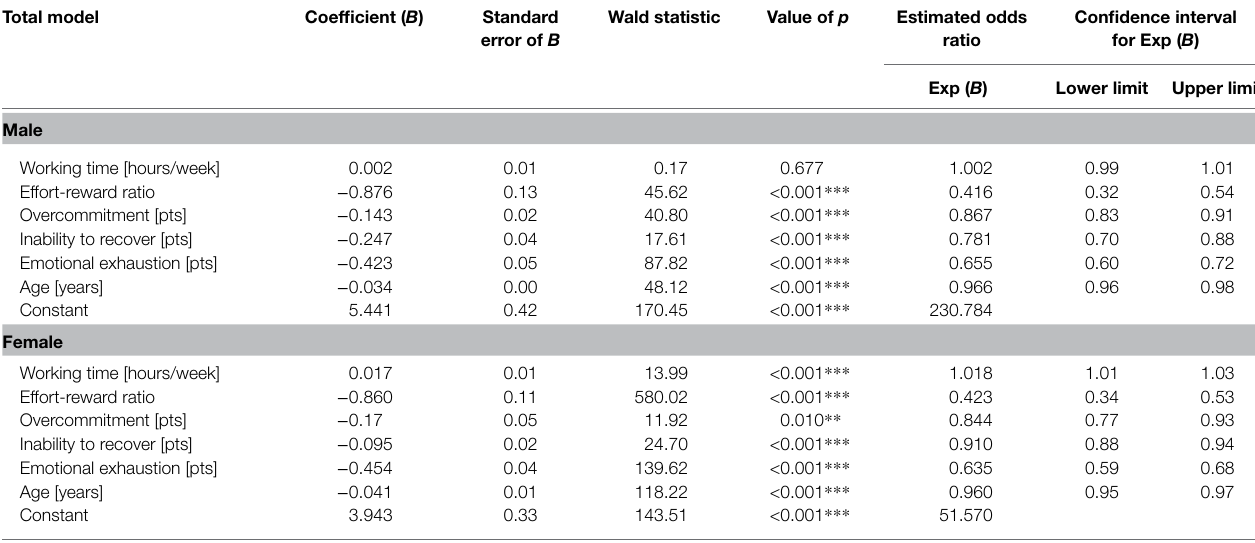
TABLE 5 | Binary logistic regression models of work-, person-, and health-related characteristics and covariates (age and subject profile) with reaching regular retirement of male ( n = 2,680) and female ( n = 3,429) full-time